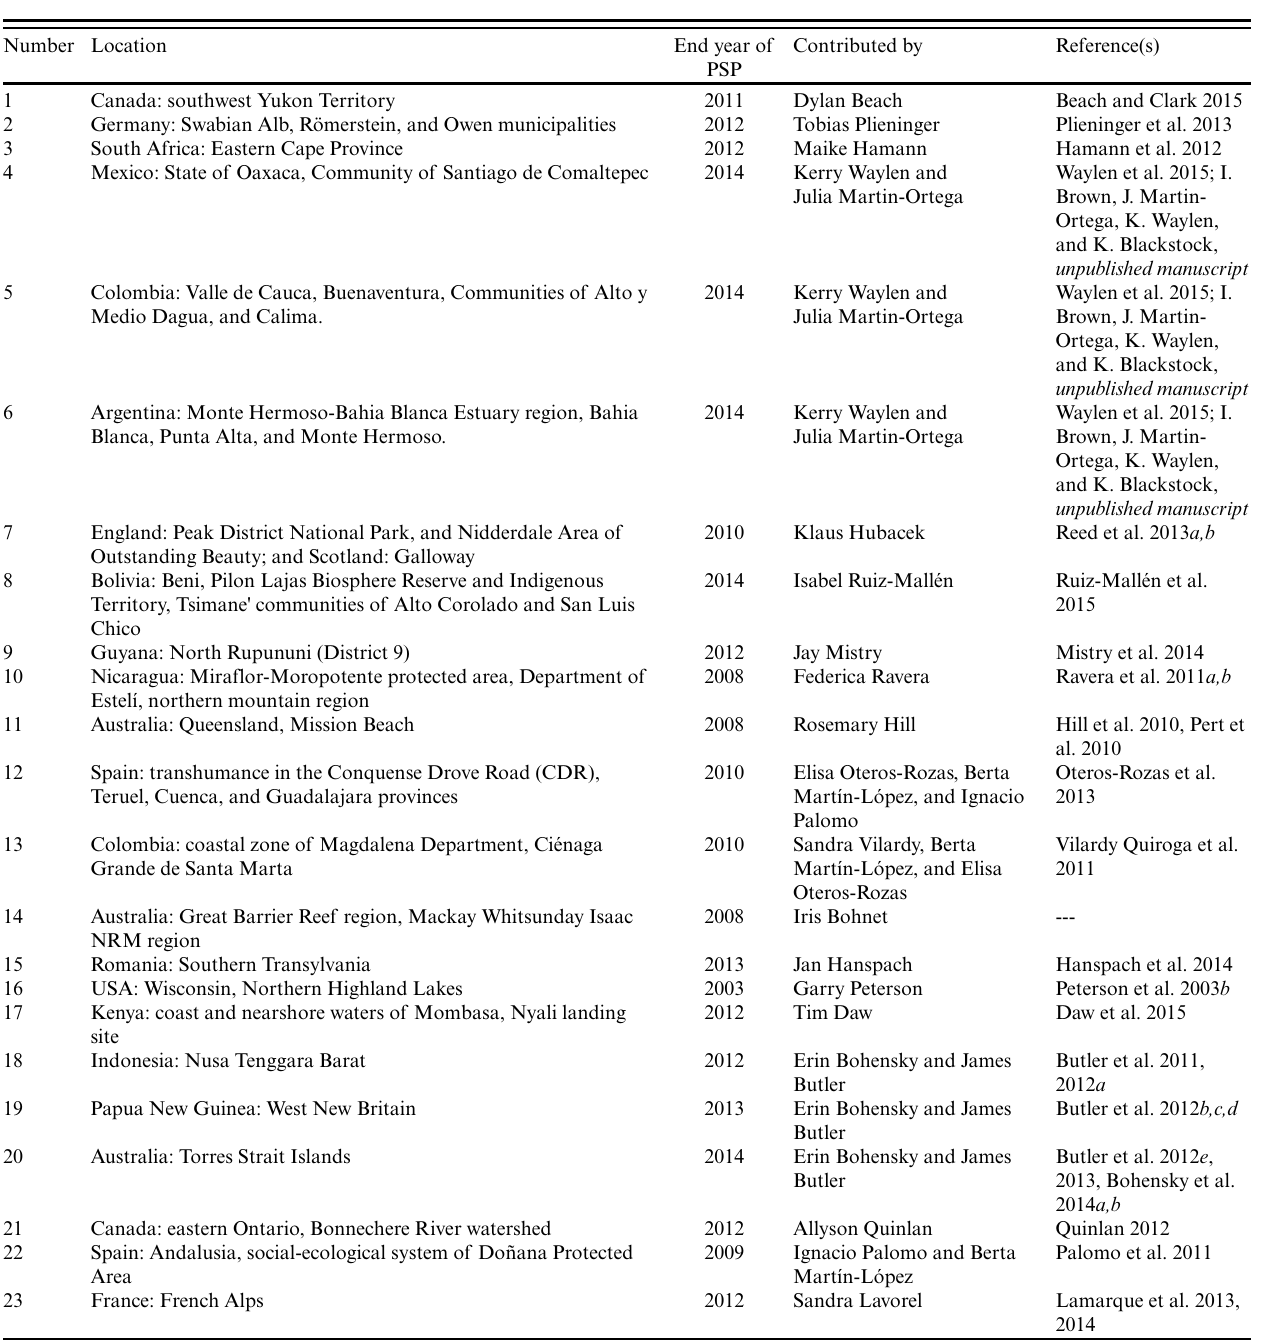
Table 1 . List of case studies analyzed. PSP = participatory scenario planning.